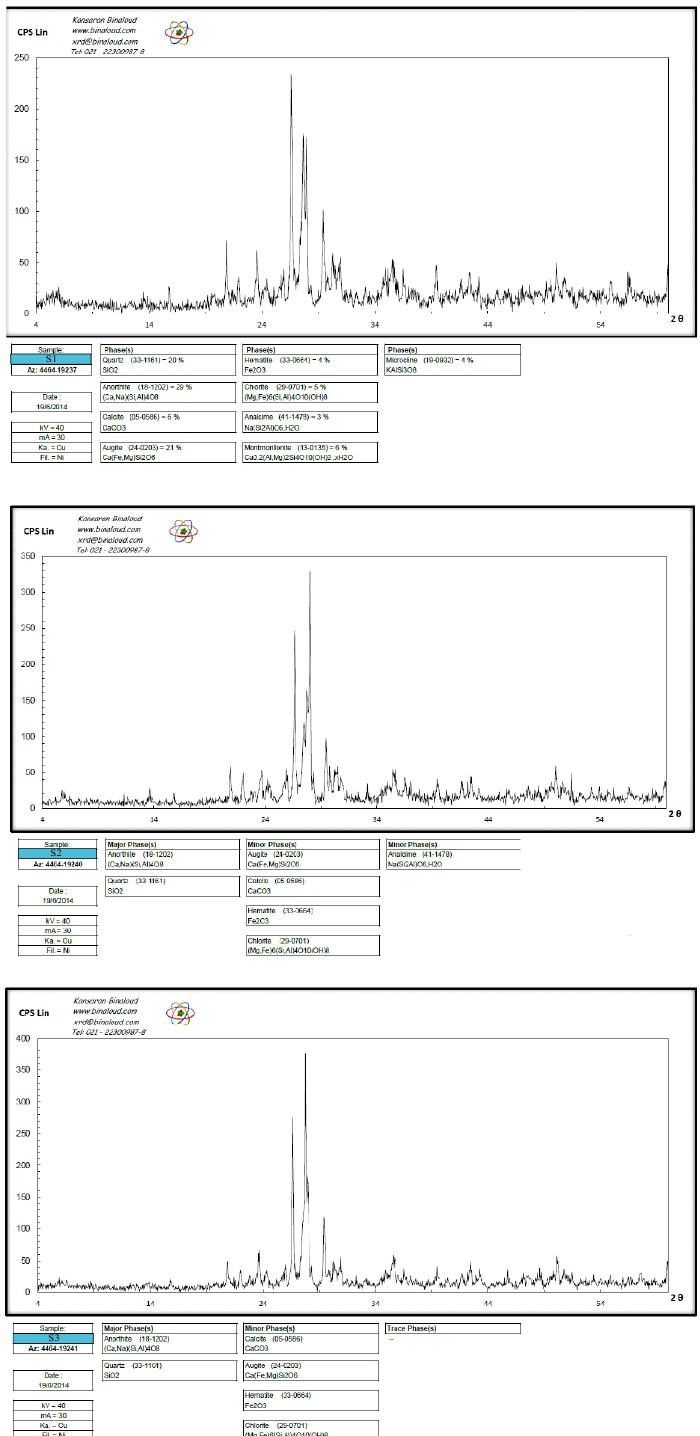
Fig. 3: XRD graphs for some of the